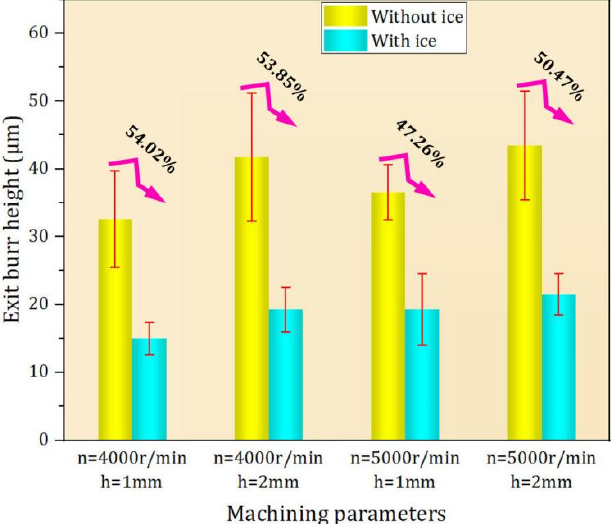
Figure 10. Suppression effect of IBC on exit burr.